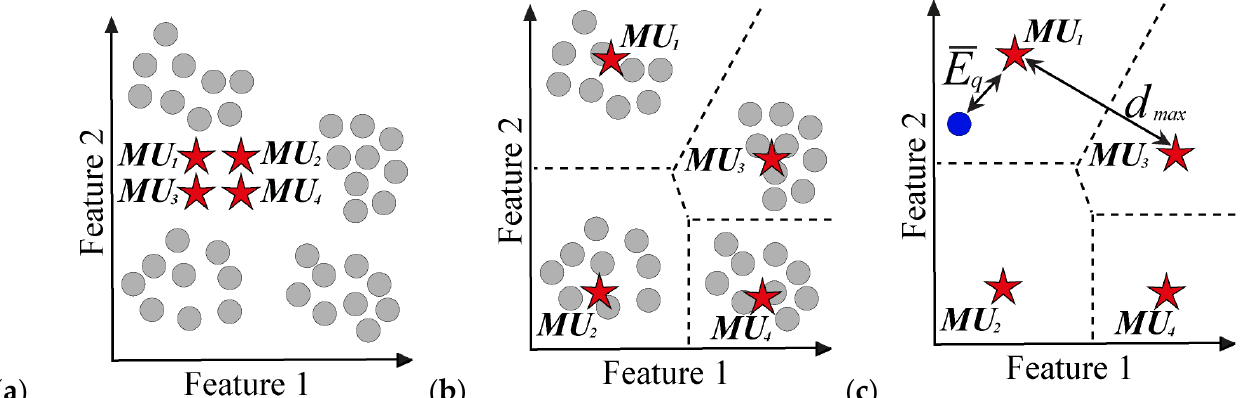
Figure 2. Representation of the self-organizing mapping procedure in a 2-dimensional input and output spaces. ( a ) Input feature space, , and a randomly initialized 2 × 2 neuron grid, . ( b ) Resulting training procedure, where, the dotted lines represent the assigned memberships regions of the matching units considering Euclidian distances. The maximum distance between MUs , dmax , corresponds with MU 1 and MU 3 . ( c ) Assessment of a new input data sample, . Assignation to MU 1 as closest matching unit with the corresponding individual quantization error 𝐸(cid:3364) (cid:3044) .